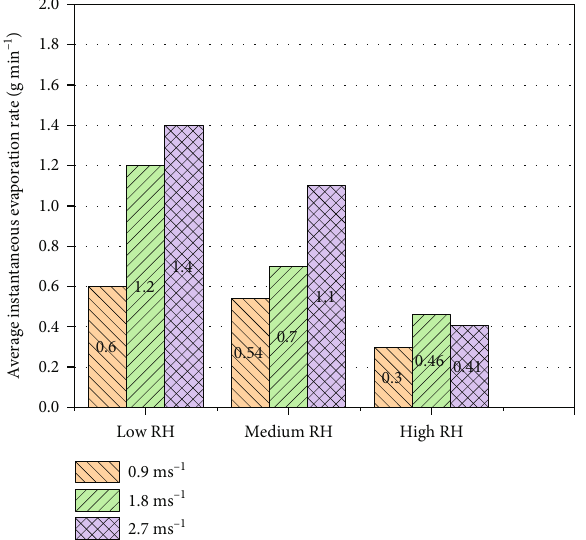
Figure 18: Average instantaneous evaporation rate of the air cooler at three di ff erent velocities under three di ff erent RH conditions.